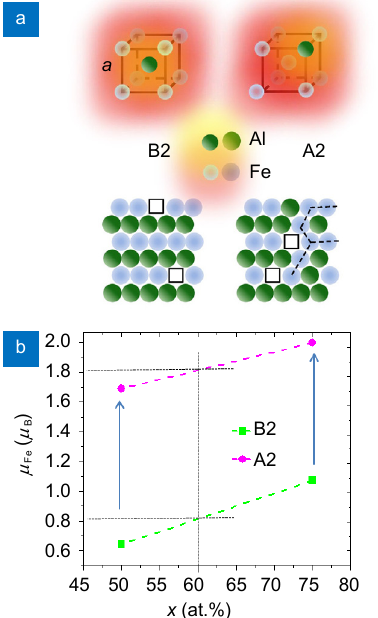
Fig. 4 | ( a ) Fe-based unit cells (top) and the (100) projections (bottom) of the atomic structure in the chemically ordered B2 and disordered A2 states of the Fe x Al 100- x ( x  50 at.%) alloy. The open boxes are vacancies in the lattice through which the atomic jumps occur for relaxation of the system to its thermodynamic equilibrium. In the A2 state there are magnetic percolation paths (dashed lines). ( b ) Simulated change of magnetic moments in Fe under the transformation from the B2 to A2 state 21